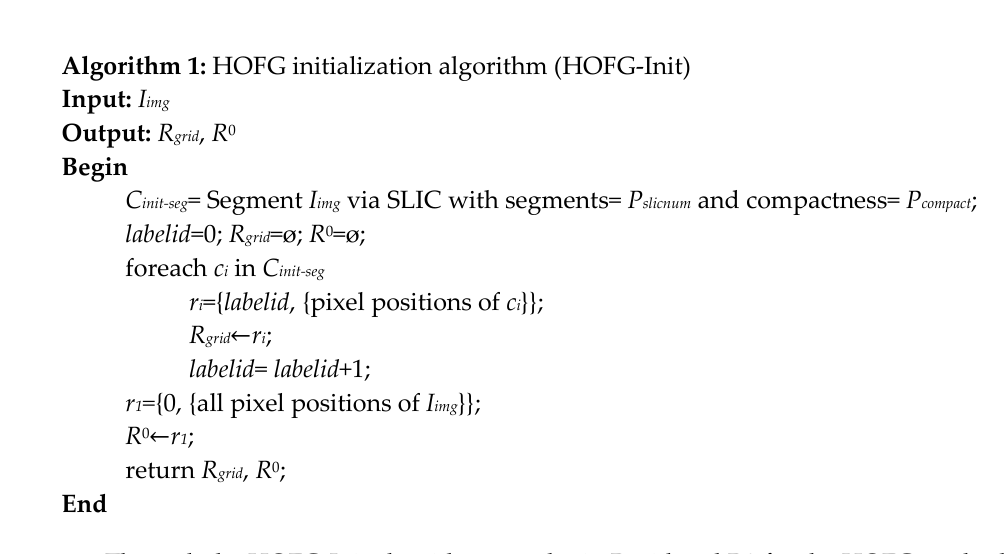
Figure 3. Unsupervised deep neural network structure and segmentation process.